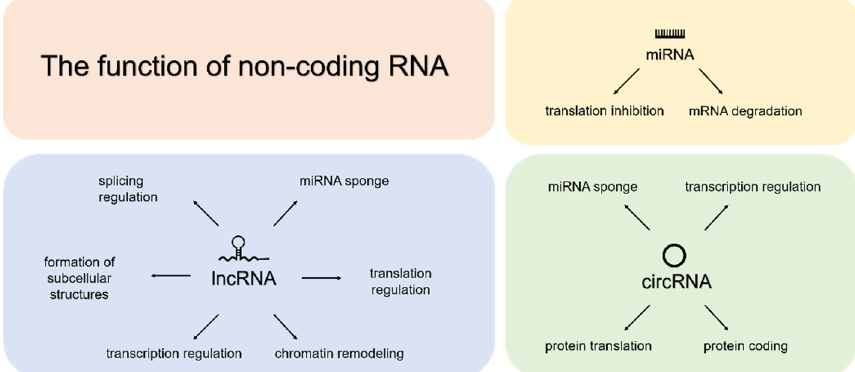
Figure 1. Graphical representation of the literature-described functions of three selected classes of non-coding RNAs: miRNAs, lncRNAs and circRNAs.